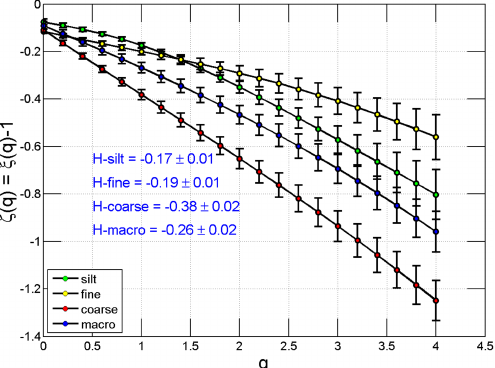
Figure 7. Scaling exponents ζ(q) estimated for different particle sizes using the HSA